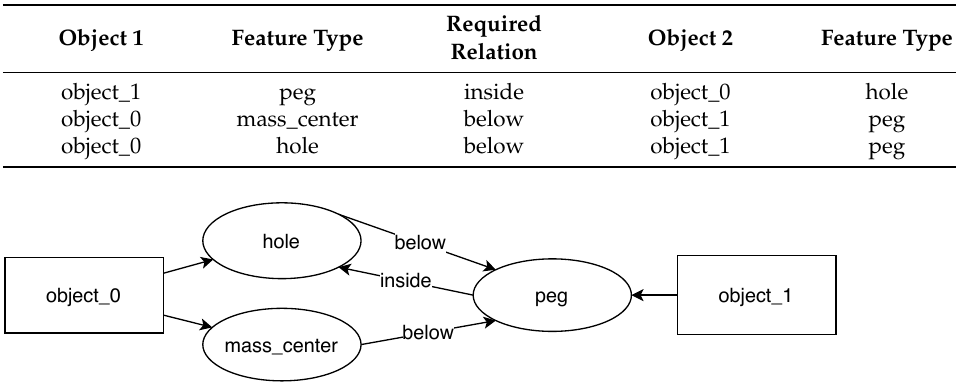
Figure 5. A graph representing learned skill